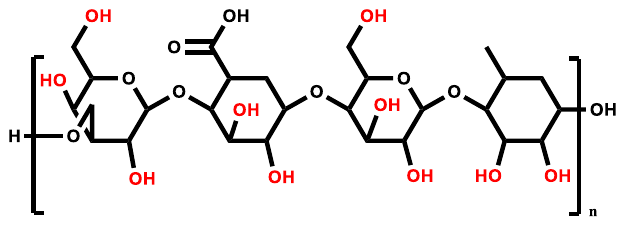
Figure 1. Chemical structure of the Gellan Gum repeating unit.